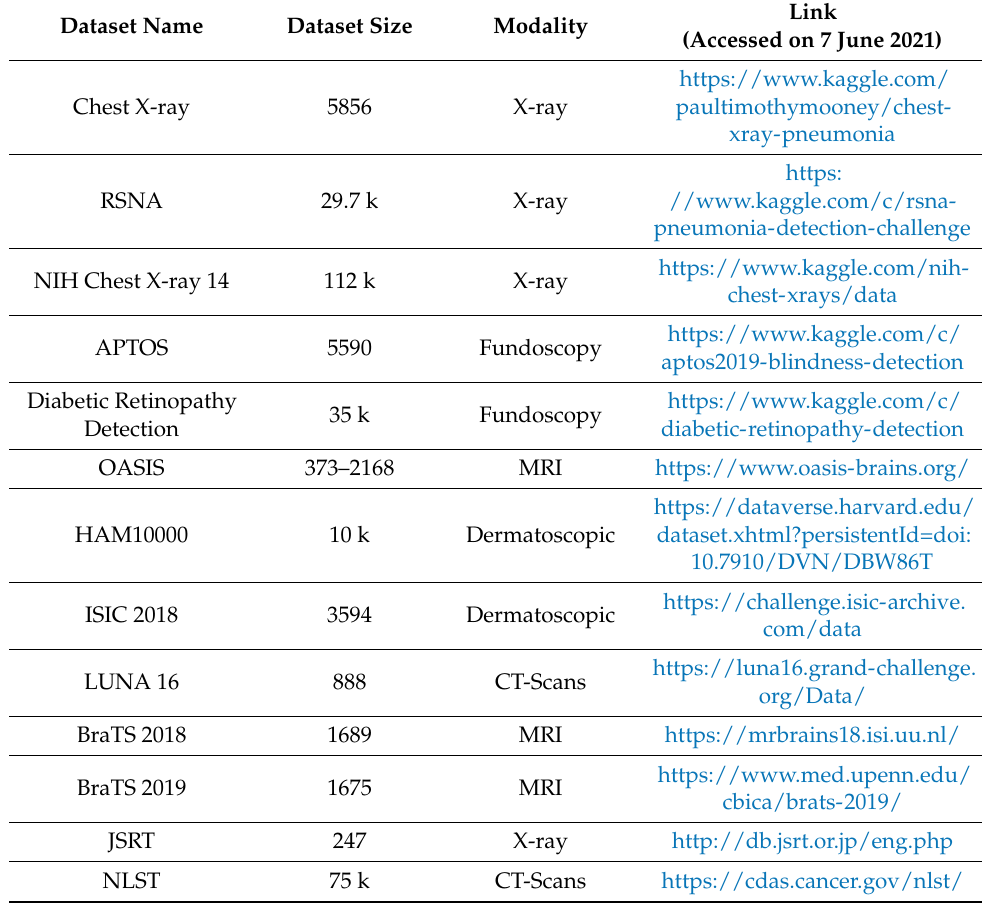
Table 6. Main characteristics of the datasets commonly used in medical adversarial deep